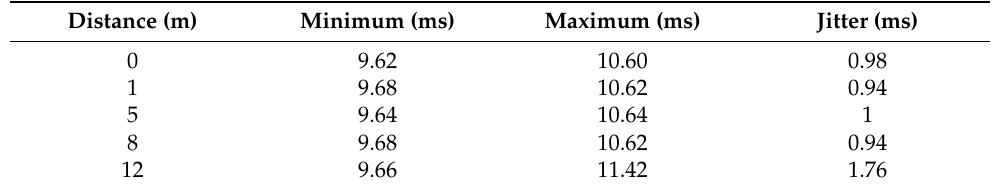
Figure 9. Scenario 1: distributed simple sampling of 5 SMNs with 4 connected sensors each. Table 2. Maximum and minimum latency values and jitter at the reception of a broadcast measuring command.